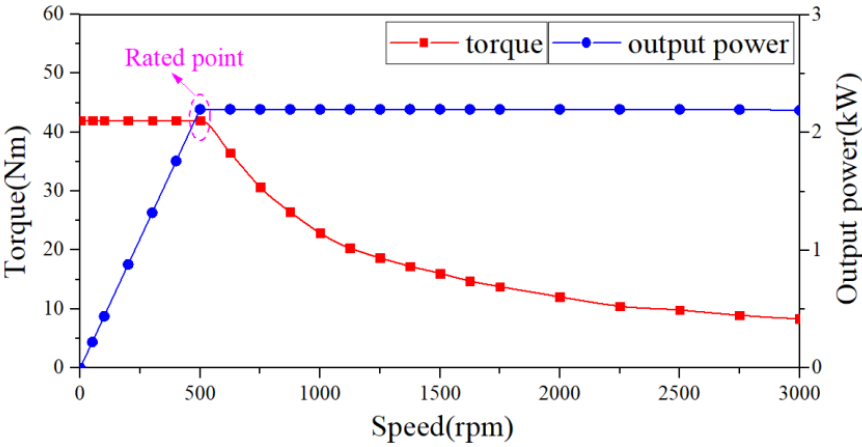
Figure 12. Output-power characteristic of TF-CFRM in the analysis.